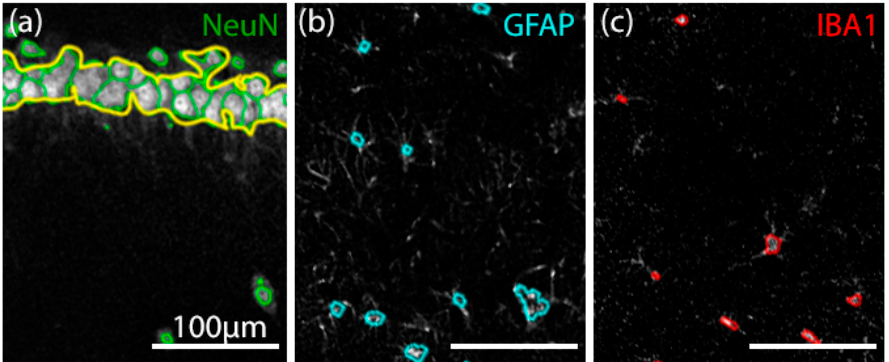
Figure 2. Analysis of different cell types by a cell-counter algorithm. ( a ) NeuN+ cells (green) with an explicitly delimited pyramidal layer (yellow), ( b ) GFAP+ (cyan), and ( c ) IBA1+ (red) cells evidentiated and contoured by our custom cell-counter algorithm. All three immunostainings are superposed in their z ‐ stack maximum ‐ intensity projections.